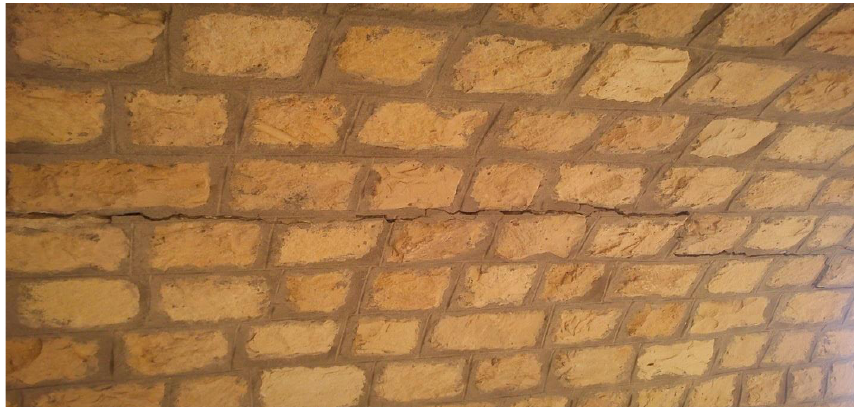
Figure 21. Damage in the wall of the bridge No. 5.